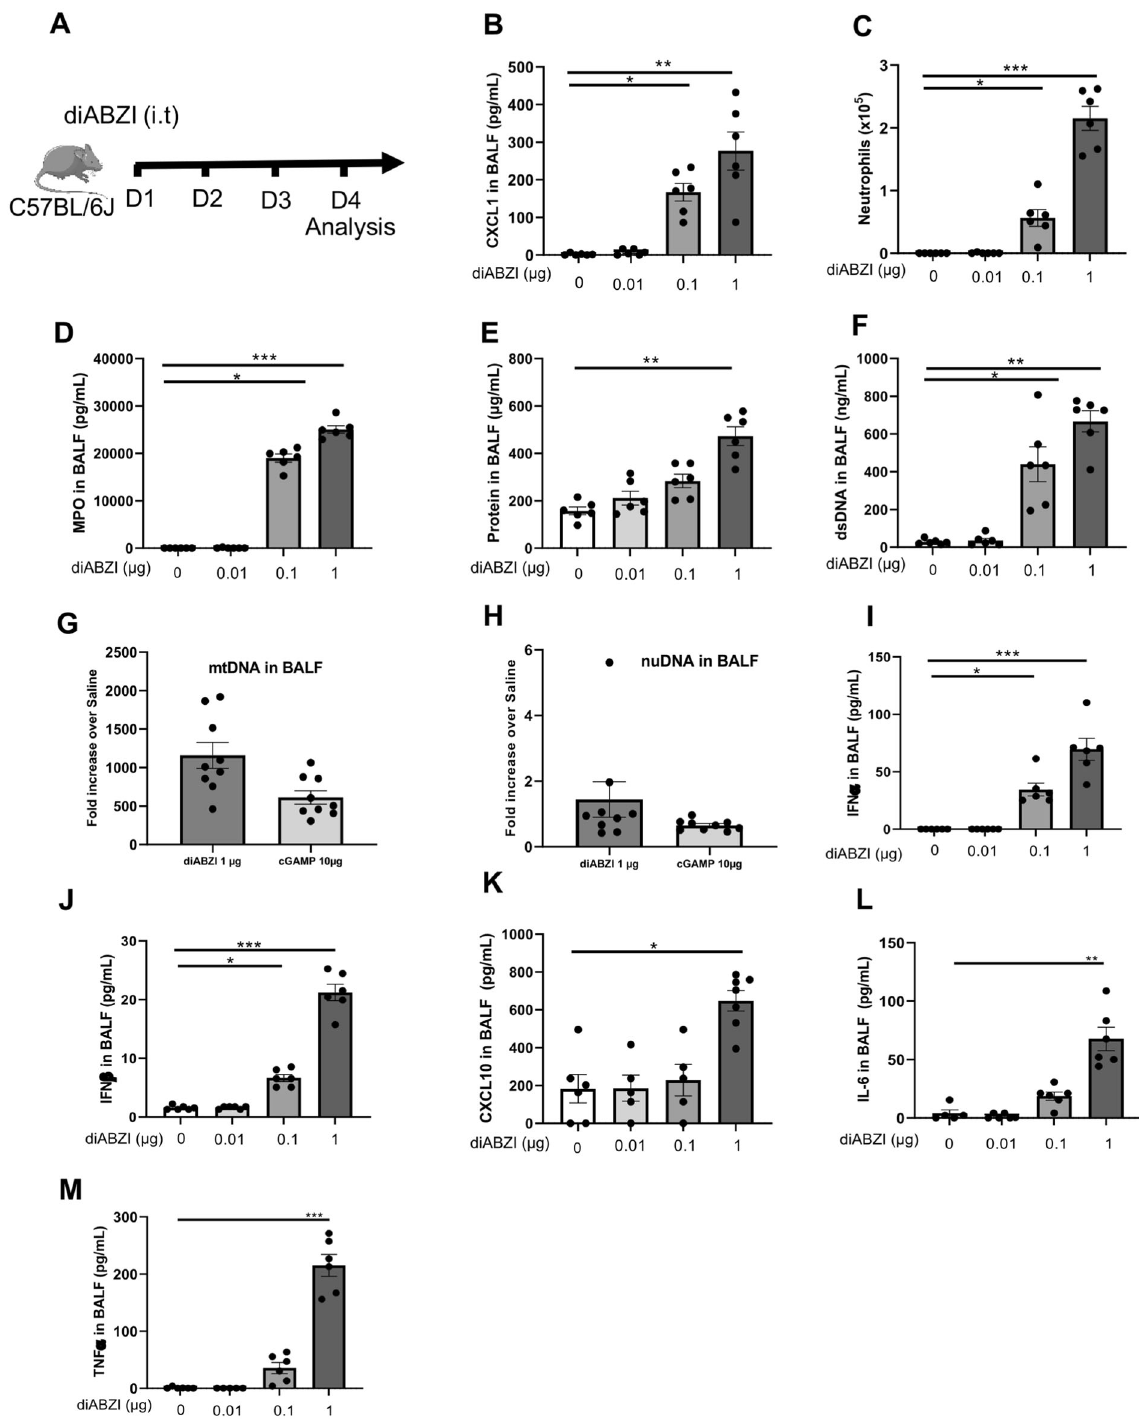
Fig. 4 STING agonist diABZI triggers neutrophilic airway in fl ammation. A STING agonist diABZI (0.01, 0.1, or 1 µg, i.t.) DMSO (0.25%) vehicle or saline were administered daily in WT mice for 3 consecutive days and parameters were analyzed on day 4. B Concentration of CXCL1/KC in the bronchoalveolar lavage fl uid (BALF) determined by ELISA. C Neutrophils counts in BAL. D Concentration of myeloperoxidase (MPO) in BALF determined by ELISA. E Concentration of proteins in BALF. F Concentration of extracellular dsDNA in the acellular fractions of BAL. G , H Mitochondrial DNA (mtDNA) ( G ) and nuclear DNA (nDNA) ( H ) in the BALF after diABZI or cGAMP administration. I – M IFN α ( I ) and IFN β ( J ) determined by multiplex immunoassay, and CXCL10 ( K ), IL-6 ( L ), and TNF α ( M ) quanti fi ed by ELISA in the BALF. N Visualization of NETs in BAL and lung with the staining of DNA dye DAPI (cyan), MPO (green), and citrullinated Histone 3 (red). Bars, 20 µm. O , P Quanti fi cation of Cit-H3 staining intensity ( O ) and MPO staining intensity ( P ) in the lung. Q , R Correlation between MPO and Cit-H3 after diABZI administration at 0.1 µg ( Q ) and 1 µg ( R ). S – W Lung tissue histology PAS staining ( S ), with pathology scoring of the presence of epithelial injury ( T ), peribronchial in fi ltration of in fl ammatory cells ( U ), alveolitis ( V ), and emphysema ( W ). Bars, left panels: 2.5 mm, right panels: 250 µm. Graph data were presented as mean ± SEM with n = 5 – 6 mice per group. Each point represents an individual mouse. * p < 0.05, ** p < 0.01, *** p < 0.001, **** p < 0.0001 (Nonparametric Kruskal – Wallis with Dunn post test). Cell Death and Disease (2022)